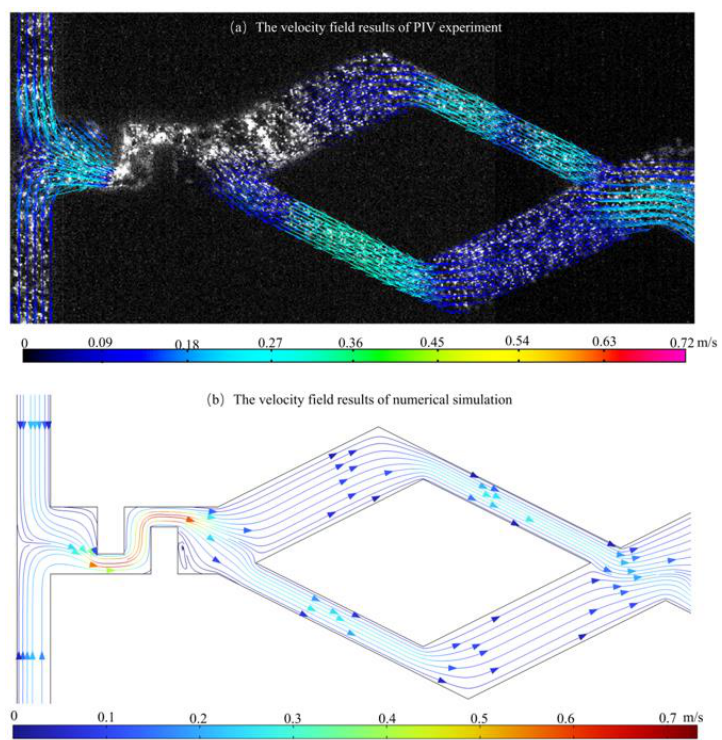
Figure 4. Fluid flow state in micromixer. ( a ) Experimental results; ( b ) Numerical results.